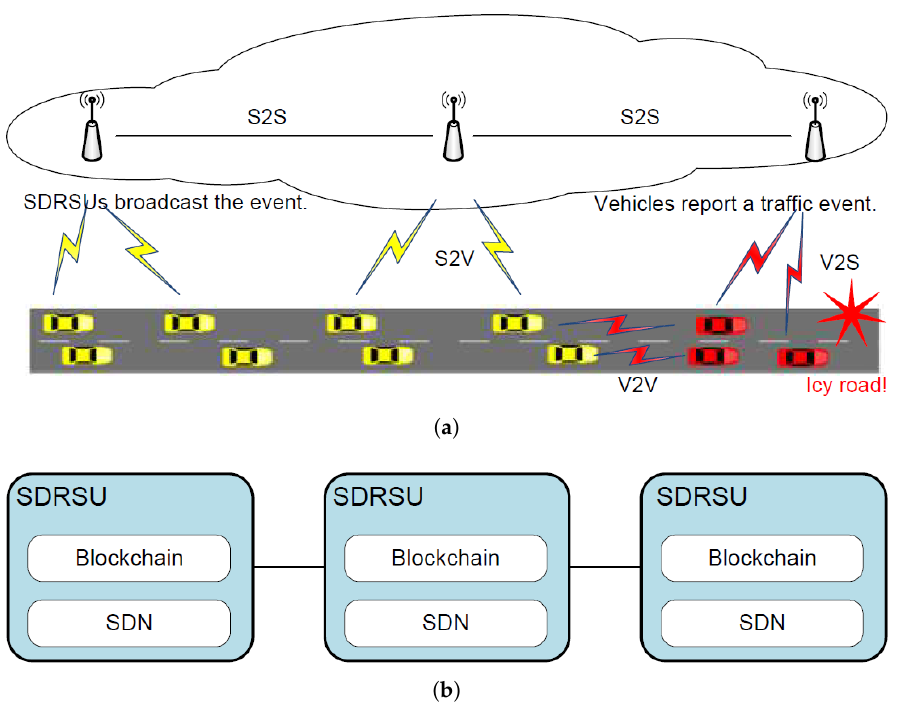
Figure 1. Quick Fake News Detection (QcFND) deployed in Internet of Vehicles (IoV). ( a ) A scenario where a traffic event happens. ( b ) Network computing framework.